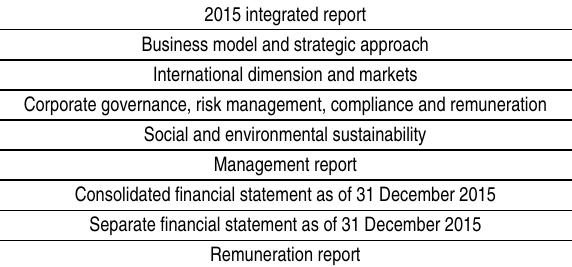
Table 3. The Sabaf’s 2015 integrated